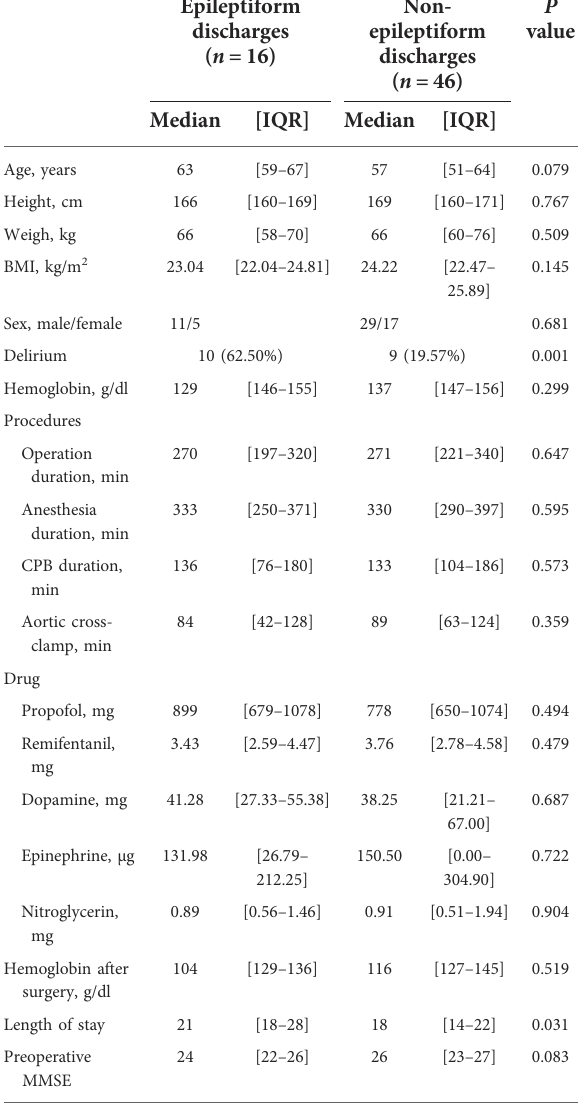
TABLE 3 Univariate and multivariate logistic regression analyses for prediction of postoperative delirium in patients after